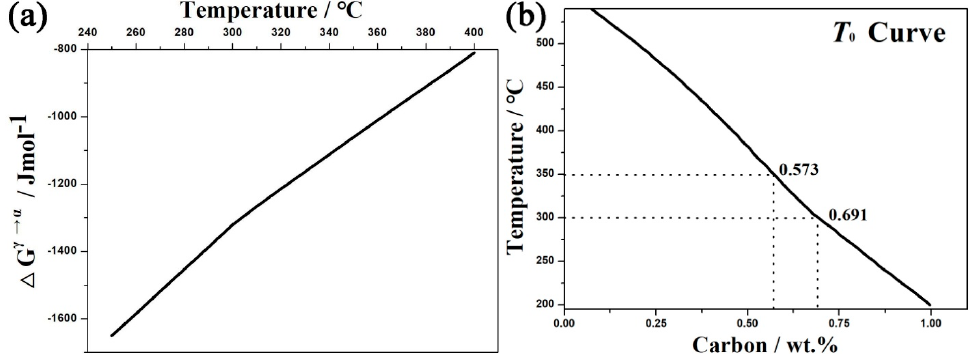
Figure 7. ( a ) The free energy change ∆ G γ → α as a function of temperature; ( b ) Calculated T (cid:48) 0 curve of the tested steel.